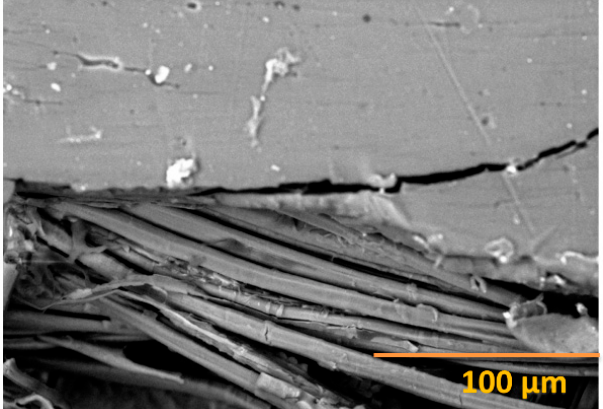
Figure 8. Tensile test for the PLA/flax fiber composites breaking area after the test. Figure republished from Alpár, Markó, and Koroknai (2017), with permission from John Wiley & Sons [123]. Copyright John Wiley & Sons, 2017.